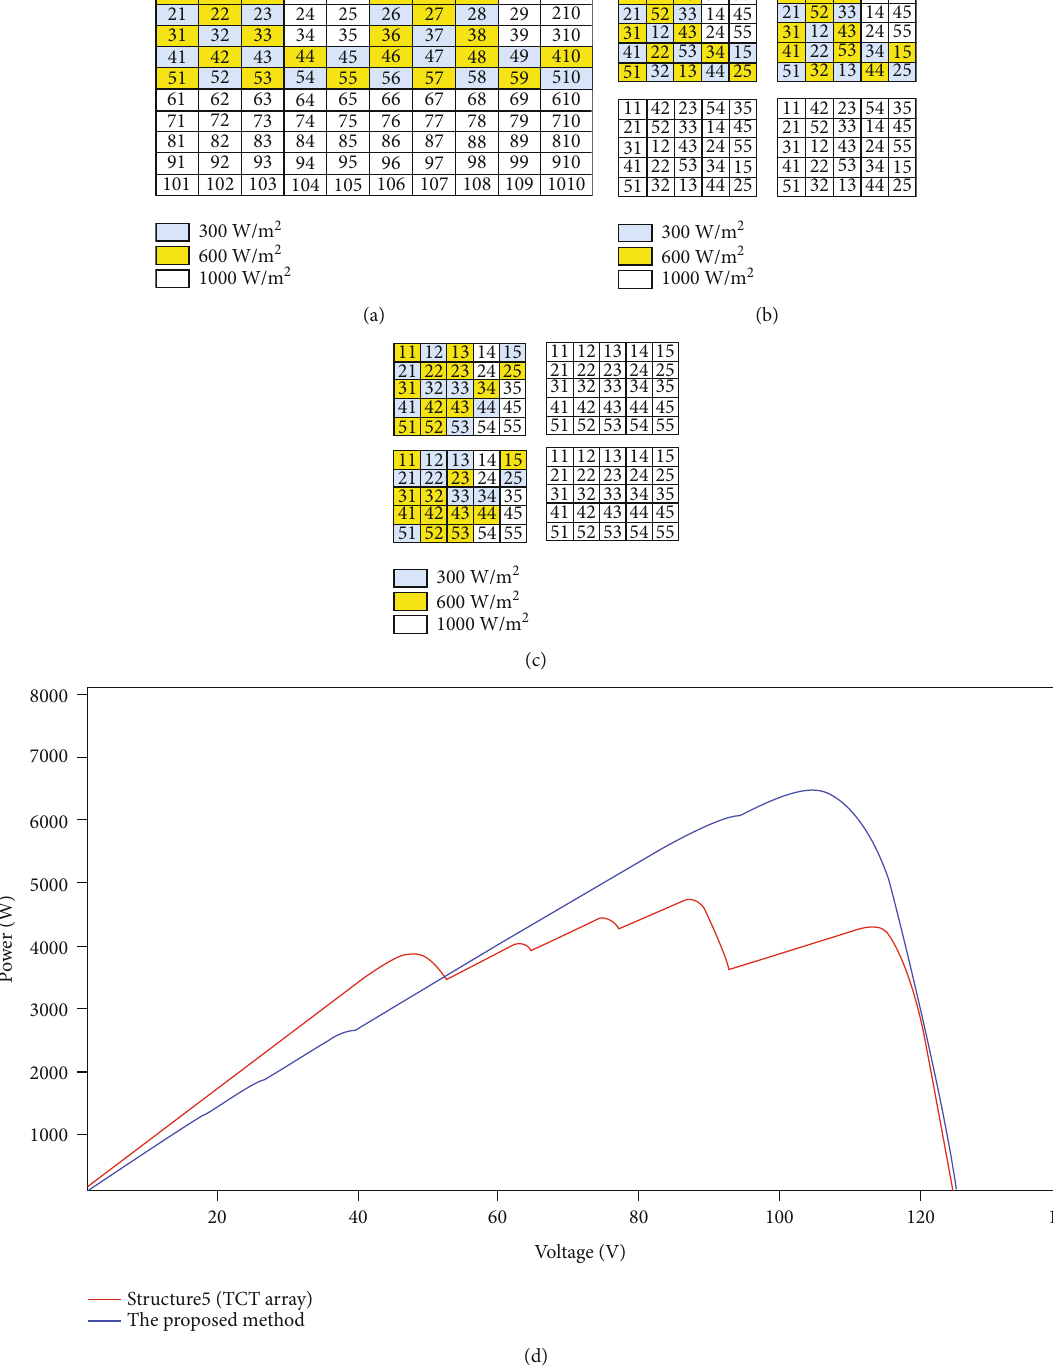
Figure 13: Fourth shading pattern. (a) TCT array. (b) The proposed method before recon fi guration. (c) The proposed method after recon fi guration. (d) The PV array characteristics for the TCT array and the proposed